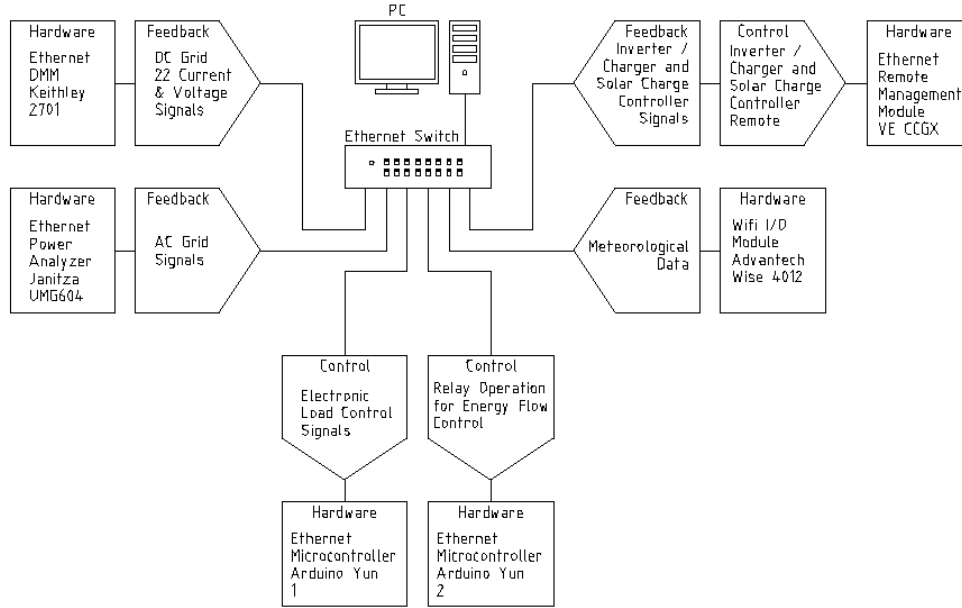
Figure 2. Measurement and control implementation of the PV-BAT system as a block diagram showing the instrumentation and the equipment used in this study.